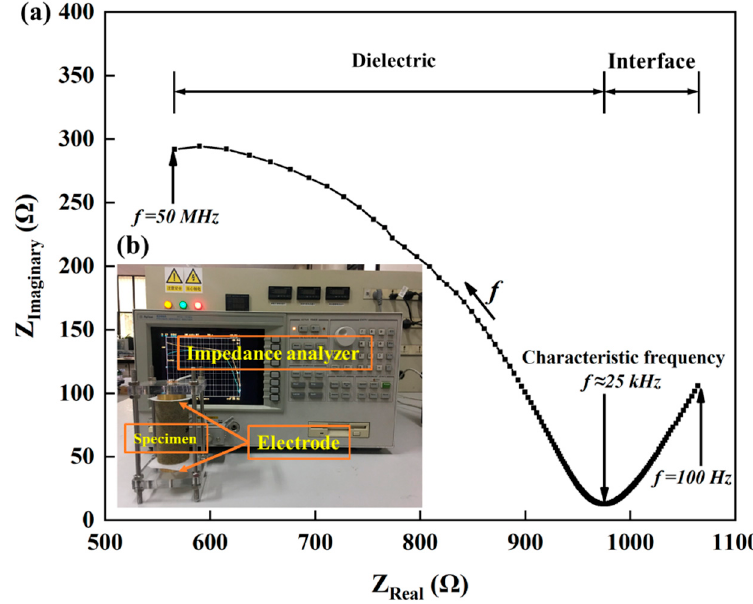
Figure 6. ( a ) Nyquist diagram and ( b ) EIS testing.